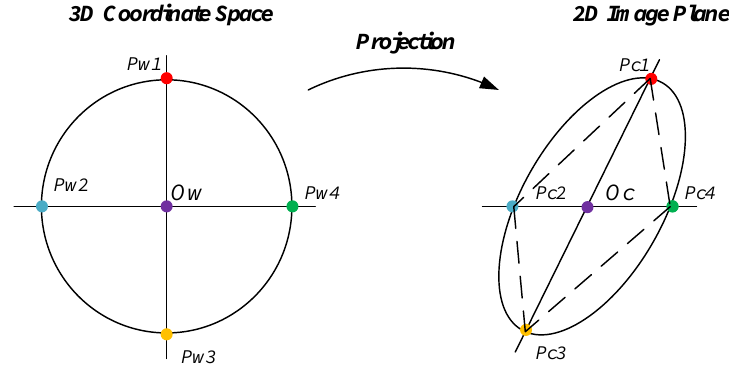
Figure 10. Feature points projection of circular target.